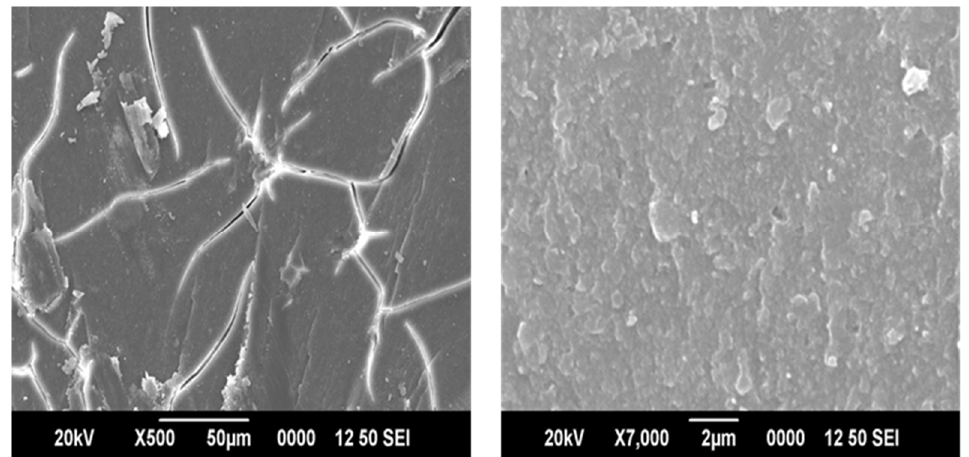
Figure 7. SEM analysis of Fucoidan from Sargassum ilicifolium .